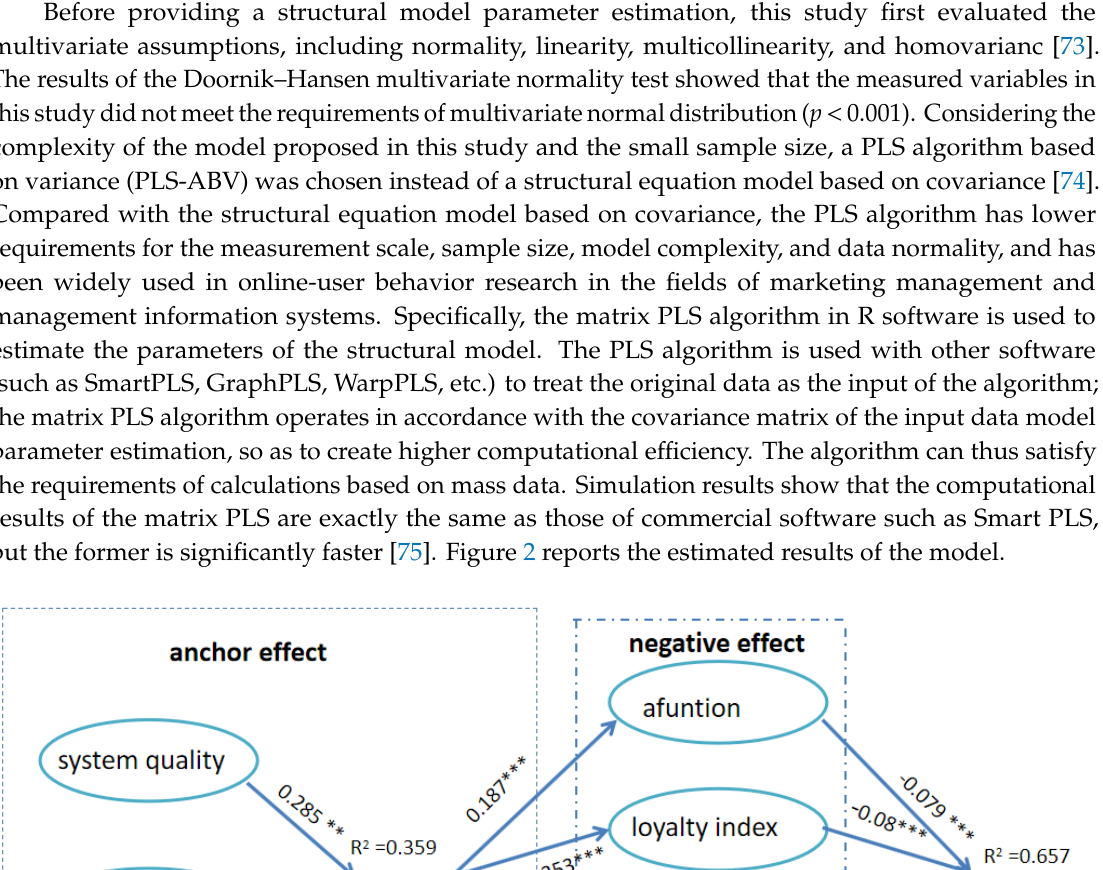
Table 3. Results of the mediating effect.